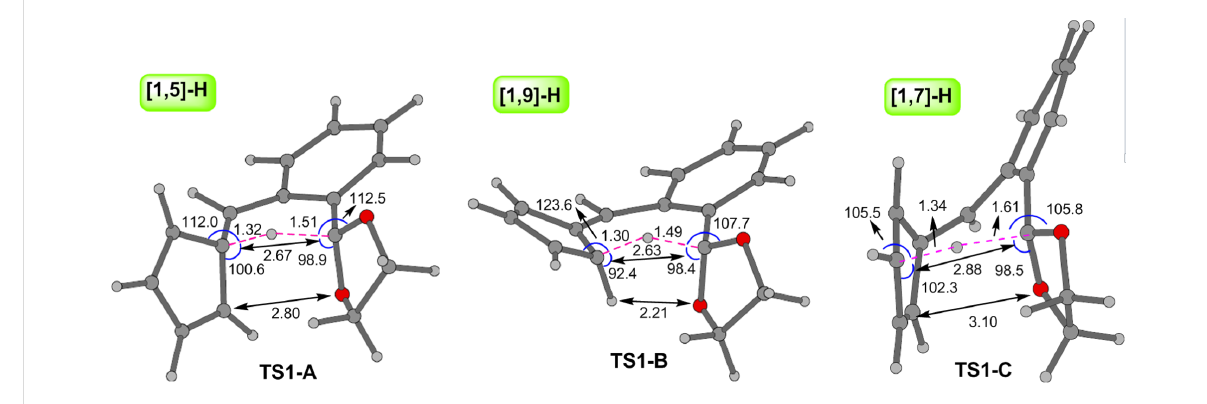
Figure 1: Optimized geometry of transition structures TS1-A , TS1-B , and TS1-C computed at the B3LYP/6-31+G** theoretical level. Distances in Ångstroms, bond angles in degrees.